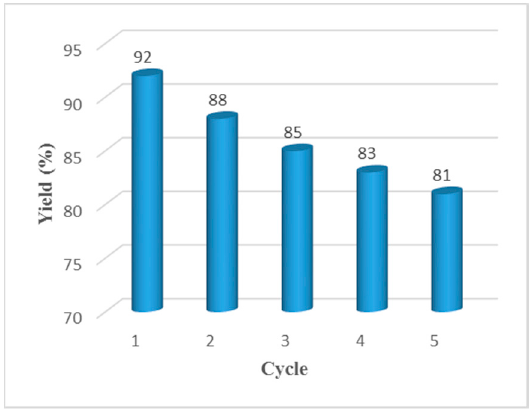
Figure 2. Reusability studies of the catalyst for the Biginelli reaction starting directly from alcohols. Although the mechanism of Biginelli reaction has been a topic of much debate [27–31], the acidic proton and the cation of HPAIL appeared to play important roles in this tandem oxidative cyclocondensation based on the above discussions. Thus, according to the iminium route mechanism suggested by Folkers, Johnson and Kappe [113–115], a plausible mechanism for the reaction is depicted in Figure 3. Initially, the alcohol substrate was easily oxidized to aldehyde by NaNO 3 with assistance of the acidic HPAIL catalyst. The catalytic cycle starts with the activation of the carbonyl of aldehyde by the coordination with an aminium cation and N–H activation of urea by the sulfonic group in the HPAIL cation. The adsorbed aldehyde-amine species undergoes an addition of the amine to the carbonyl carbon atom to obtain the dipolar adduct. After proton-exchange, desorption and dehydration, an imine intermediate is formed with a regenerated HPAIL catalyst. Meanwhile, the HPAIL cation stabilizes the enolization of 1,3-dicarbonyl compounds to form an enolate intermediate, which undergoes the Mannich-like addition with the imine intermediate followed by intramolecular cyclocondensation. Then, the final Biginelli product is obtained, resuming the HPAIL catalyst by proton-exchange, desorption and dehydration.